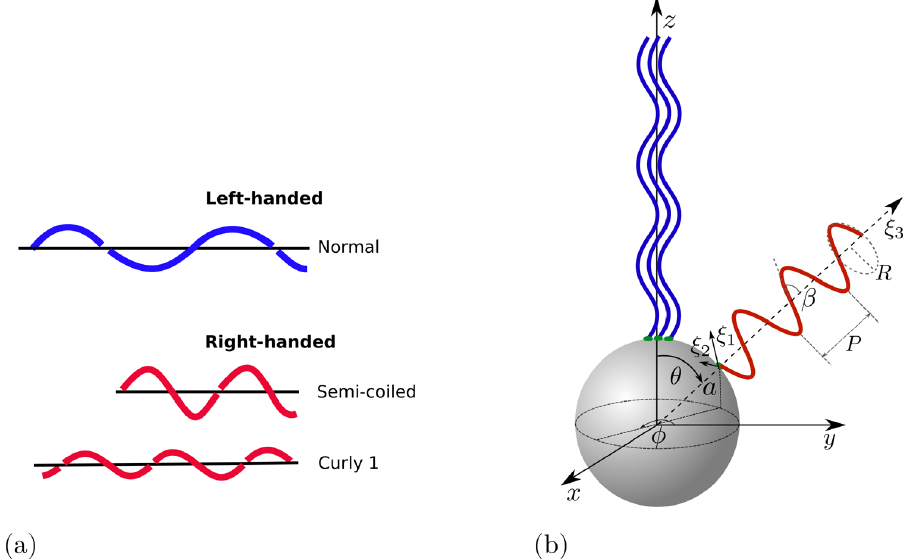
Fig 2. (a) Schematic representation of flagellar filaments with three different polymorphic forms: normal, semi-coiled and curly 1. (b) Notation for the model bacterium and the coordinate system used in the body frame. Filaments in blue are in the bundle and are aligned with z -axis. The filament in red is out of the bundle and its axis is oriented with the polar angle θ and the azimuthal angle φ relative to the axis of the bundle. The coordinate system ( ξ 1 , ξ 2 , ξ 3 ) is the local coordinate system used for the flagellum outside the bundle. The radius R , pitch P and pitch angle β of the helical filament are also shown schematically for a red helix (not to scale).